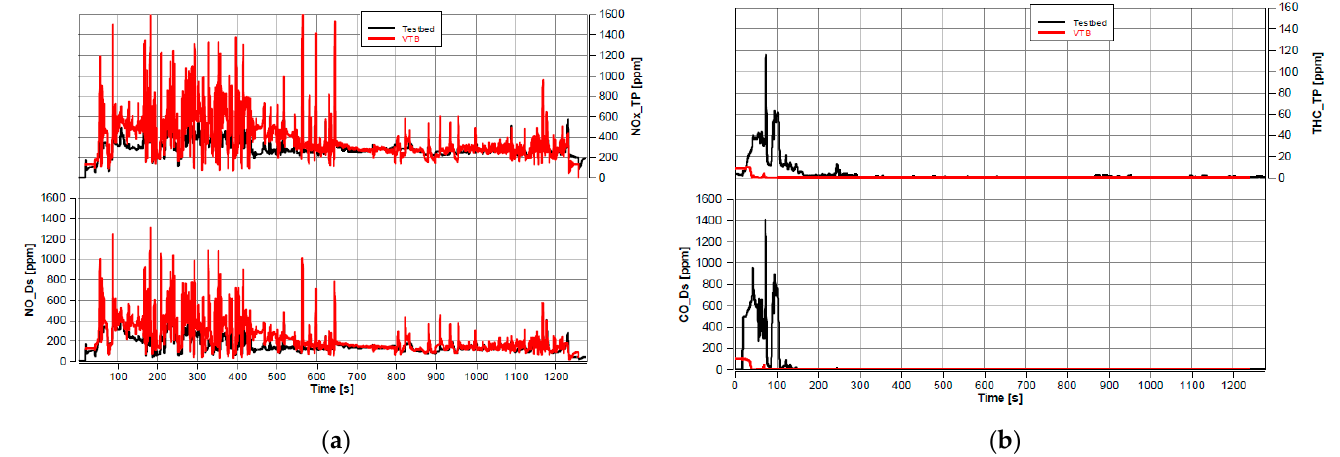
Figure 11. ( a ) Top: Simulated (red) vs. experimental (black) NO x emission downstream DOC. Bottom: Simulated (red) vs. experimental (black) NO emission downstream DOC. ( b ) Top: Simulated (red) vs experimental (black) HC emission downstream DOC. Bottom: Simulated (red) vs experimental (black) CO emission downstream DOC.